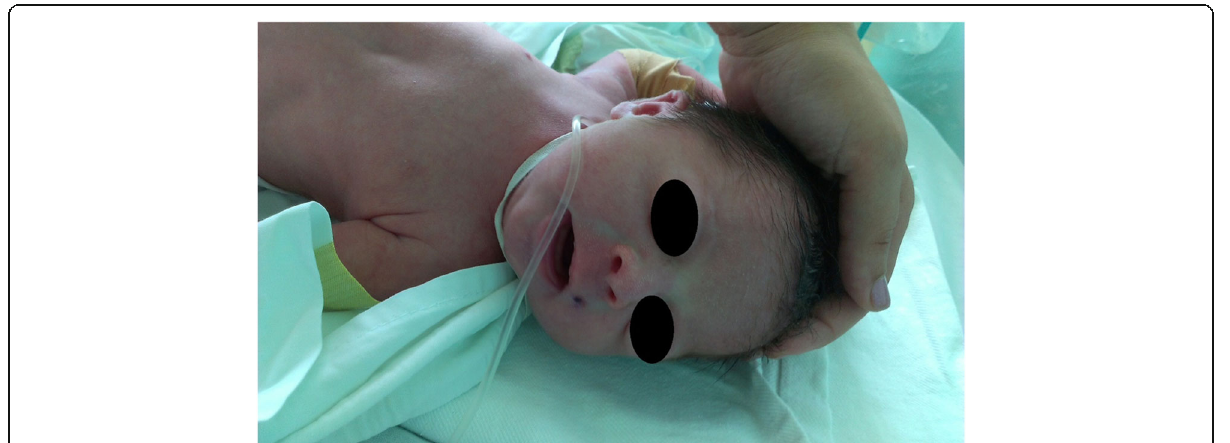
Fig. 1 Phenotype of the proband, presenting with